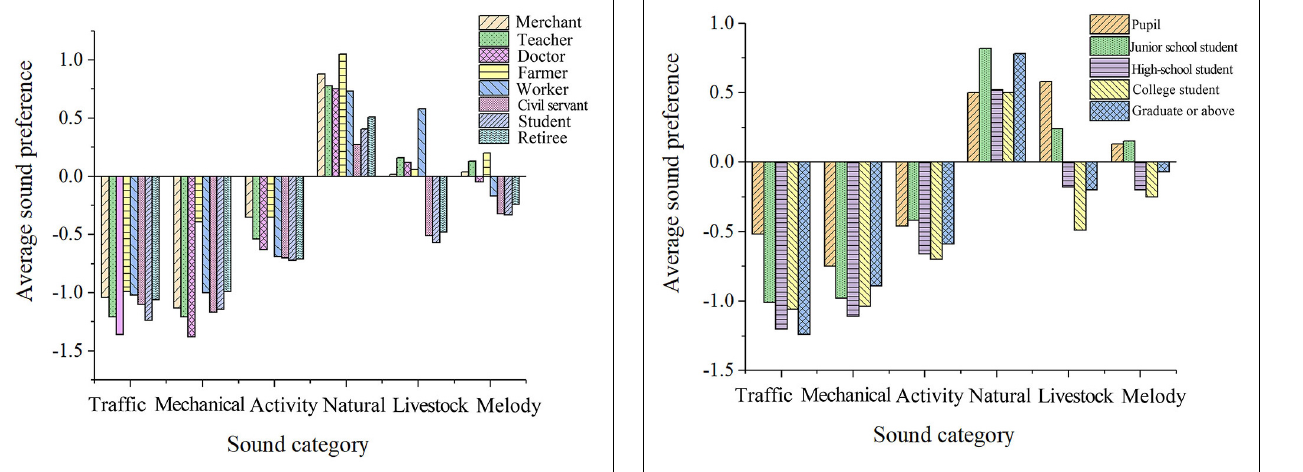
FIGURE 9 | Average soundscape preference of differently educated people.